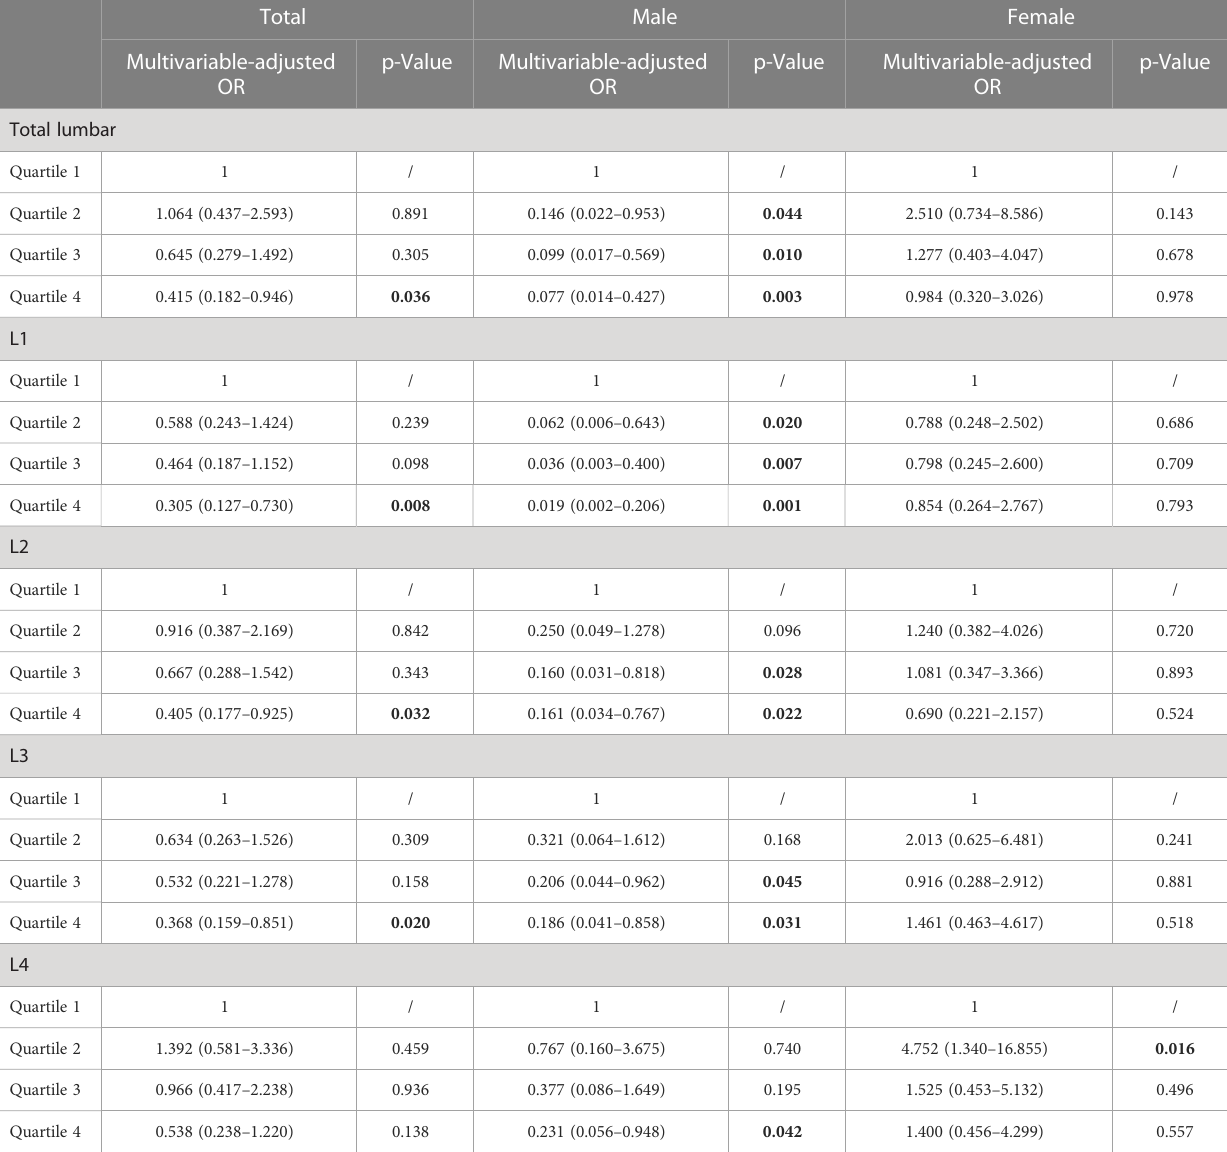
TABLE 2 Multivariable-adjusted ORs of hyperuricemia according to lumbar bone mineral density level in obese subjects. Total Male Female Multivariable-adjusted p-Value